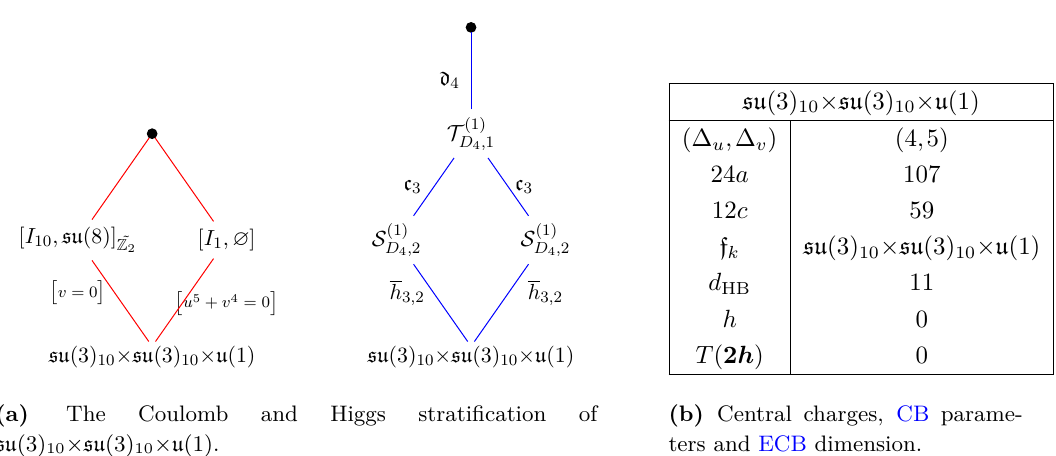
Figure 24. Information about the su (3) 10 × su (3) 10 × u (1)